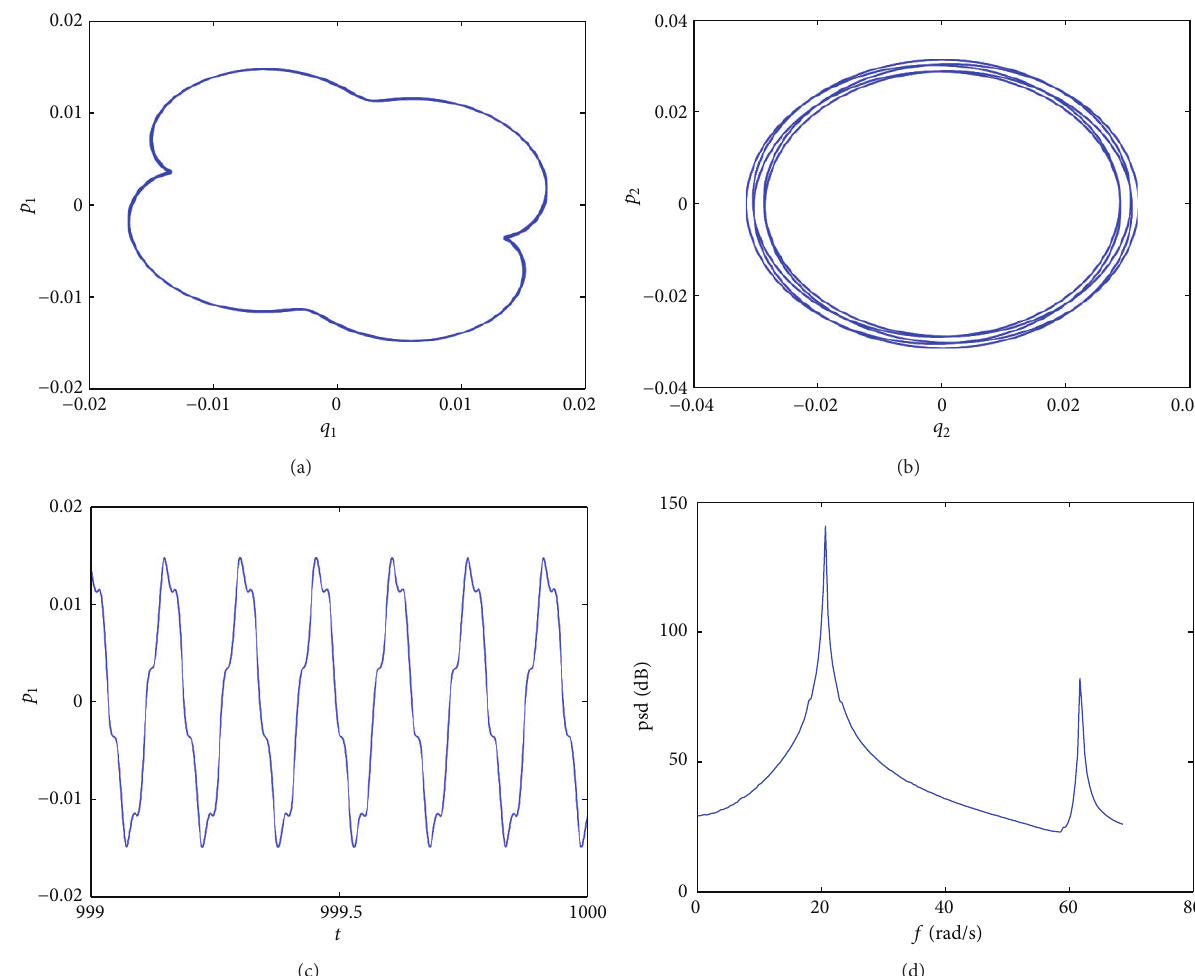
Figure 16: Phase portraits (a, b), time trace (c), and FFT power spectra (d) in the lower nontrivial stable branch of the frequency response plot of Figure 8 for 𝜎 2 = 280.5201 , 𝜇 = 0.05 , V 1 = 10 , 𝛼 = 0 , and 𝜎 1 = 92.39 .